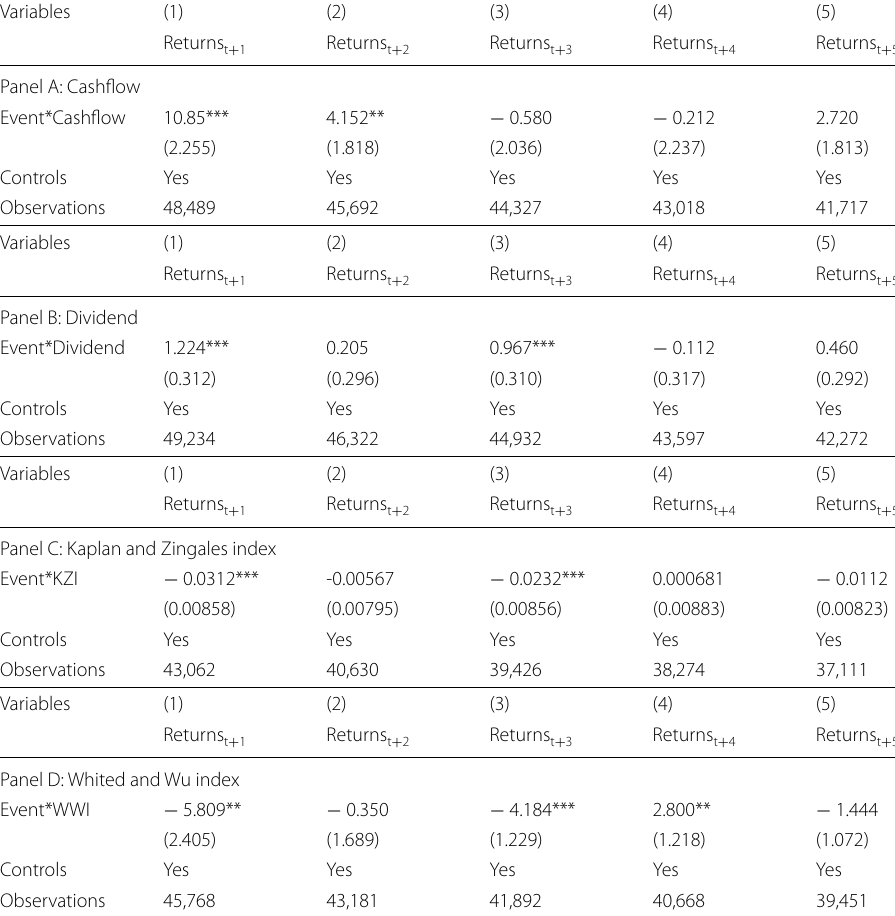
Table 6 Light a lamp, financial distress and